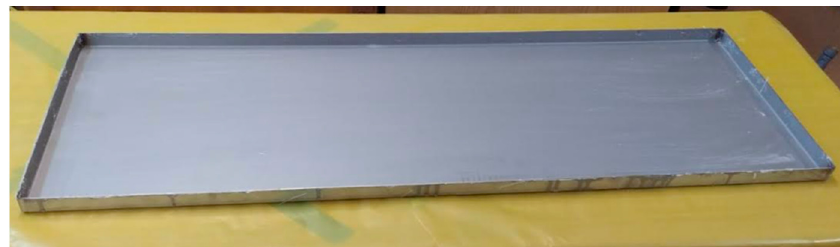
Figure 1. Mold for production of composite sample.